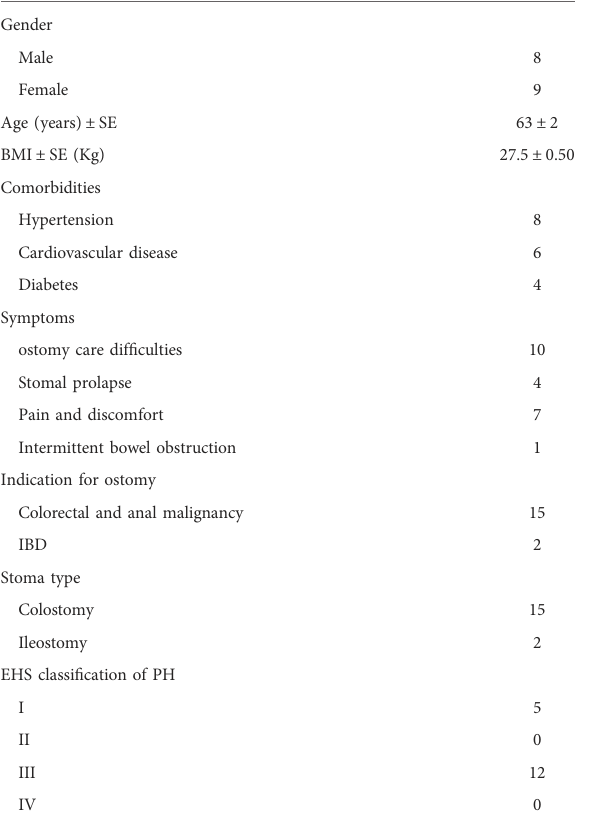
TABLE 1 Characteristics of 17 cases who underwent recurrent parastomal hernia repair. Characteristics